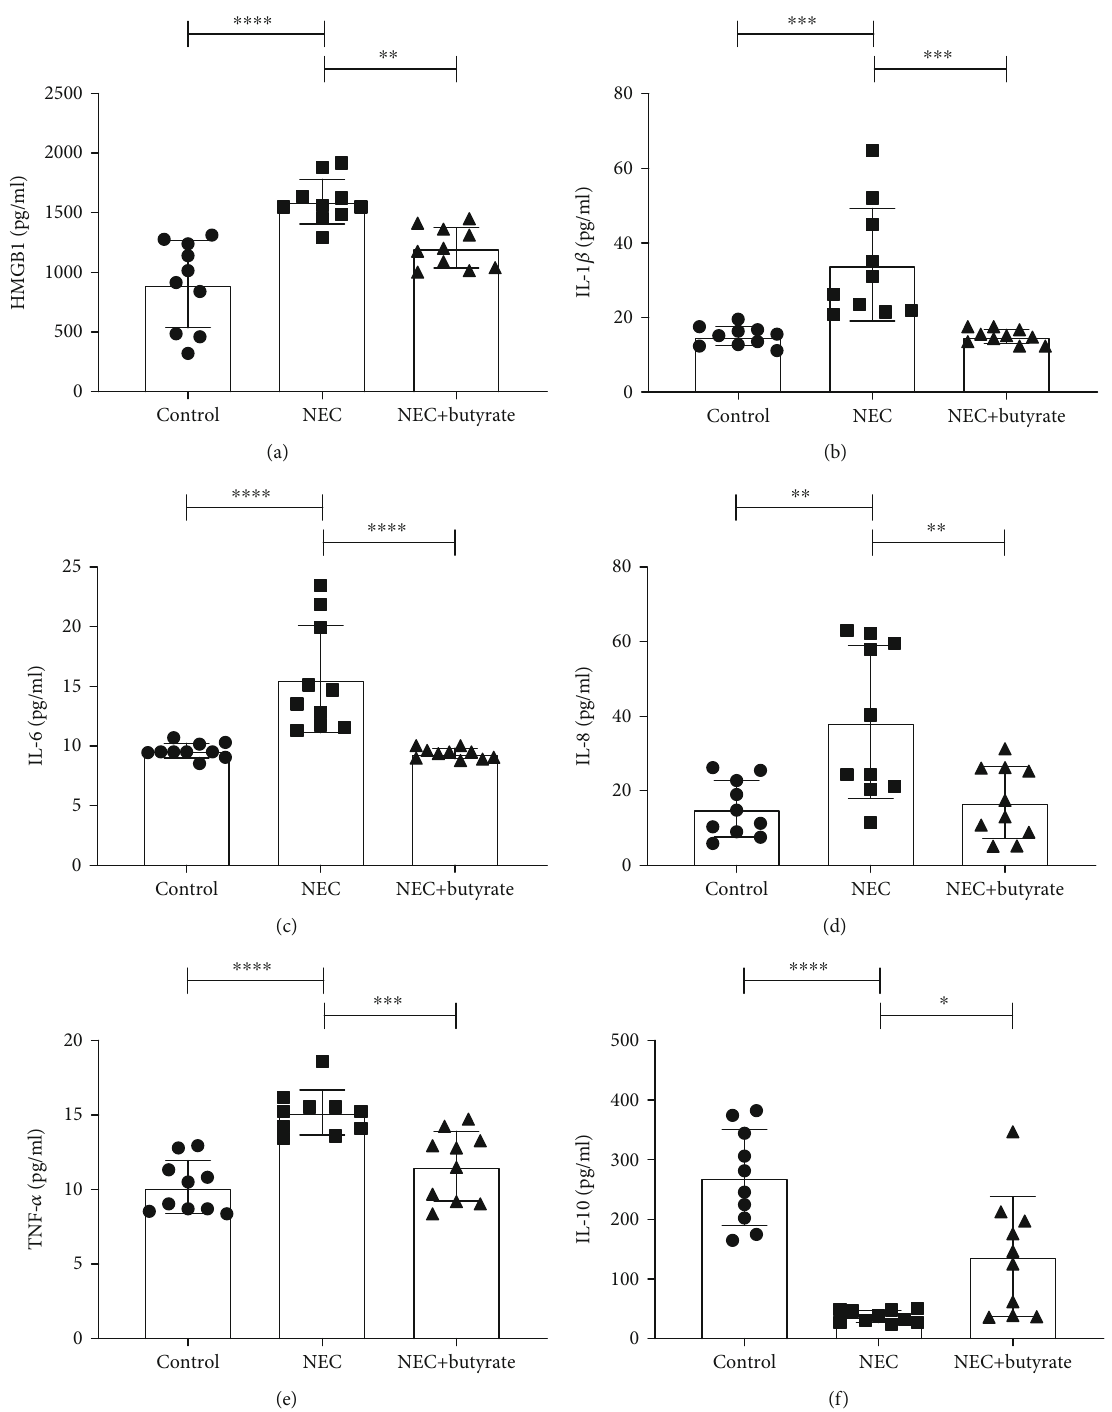
Figure 4: The protein concentrations of in fl ammatory cytokines in the three groups: (a) HMGB1; (b) IL-1 β ; (c) IL-6; (d) IL-8; (e) TNF- α ; (f) IL-10. Number of samples: control ( n = 10 ), NEC ( n = 10 ), and NEC+butyrate ( n = 10 ). Statistical analysis: one-way ANOVA. ∗ P < 0 : 05 ; ∗∗ P < 0 : 01 ; ∗∗∗ P < 0 : 001 ; ∗∗∗∗ P < 0 : 0001